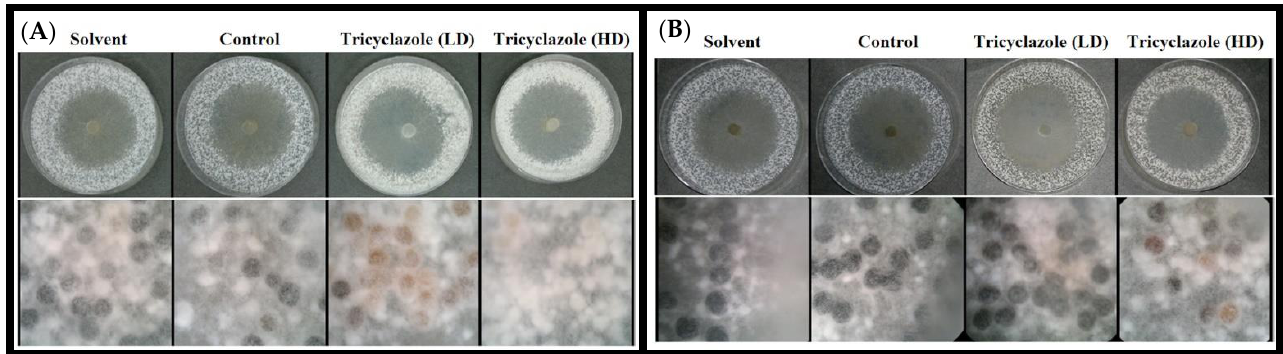
Figure 3. Melanization delay by tricyclazole in S. cepivorum . ( A ) Sclerotia at day 9 of growth and ( B ) sclerotia at day 13 of growth; top panels represent the Petri dishes, and the bottom panels represent the stereoscopic photographs of sclerotia. LD = 100 μg/mL tricyclazole; HD = 400/mL μg tricyclazole.